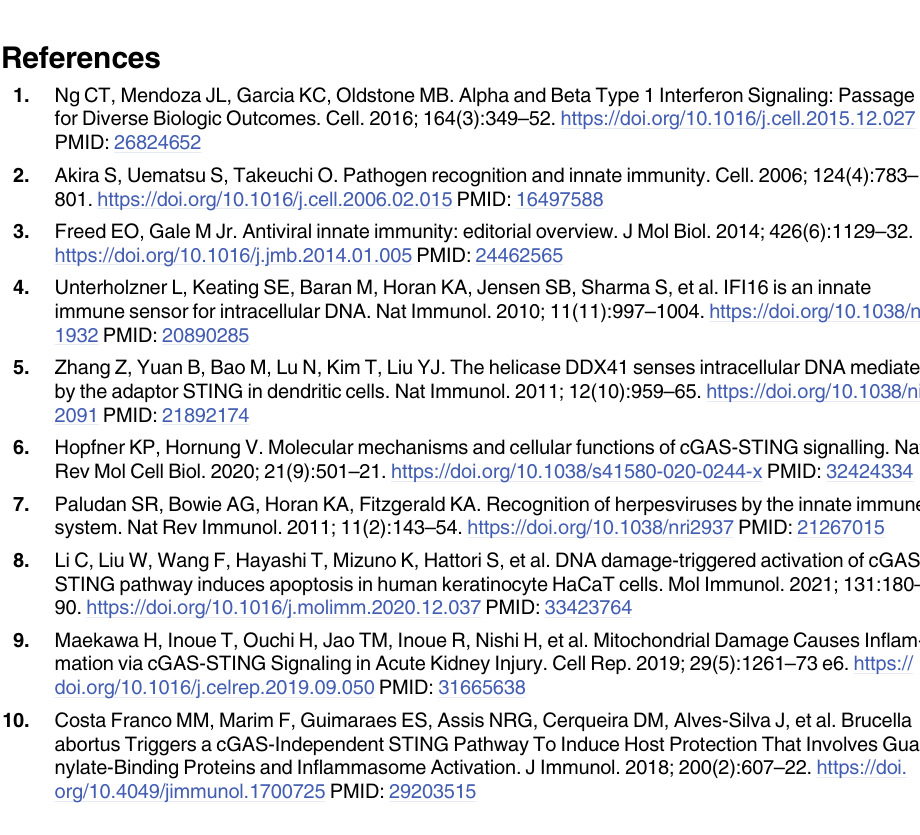
S1 Table. Table containing list of all primers, microRNA mimics and inhibitors used.